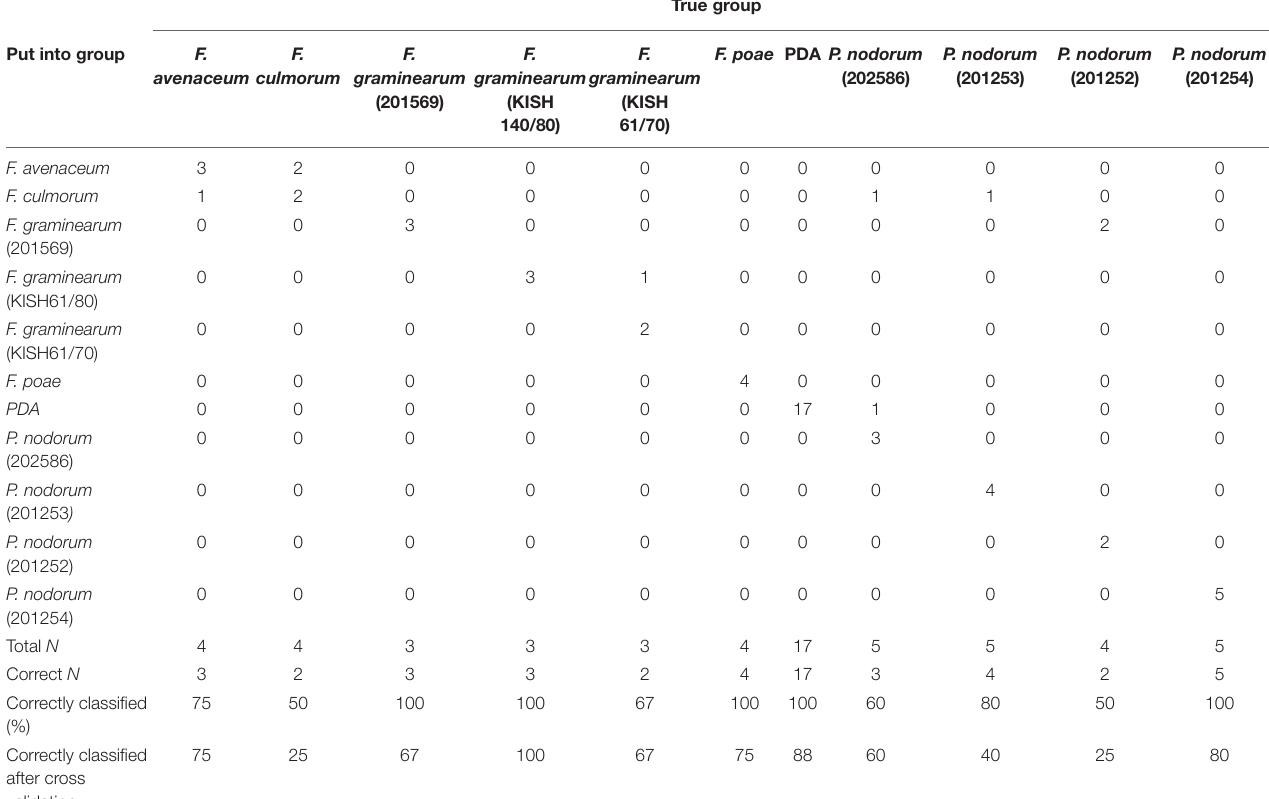
TABLE 5 | summary of classification for fungal isolates in pure culture based on linear discriminant analysis with each fungal isolate as the response factor and octanal; 2-non-anone; 1-octen-3-ol; 3,5,5-trimethyl-2-hexene; germacrene D; α -patcholene; 2-(1-cyclopent-1-enyl-methylethyl) cyclopentanone; acoradiene, and mellein as the